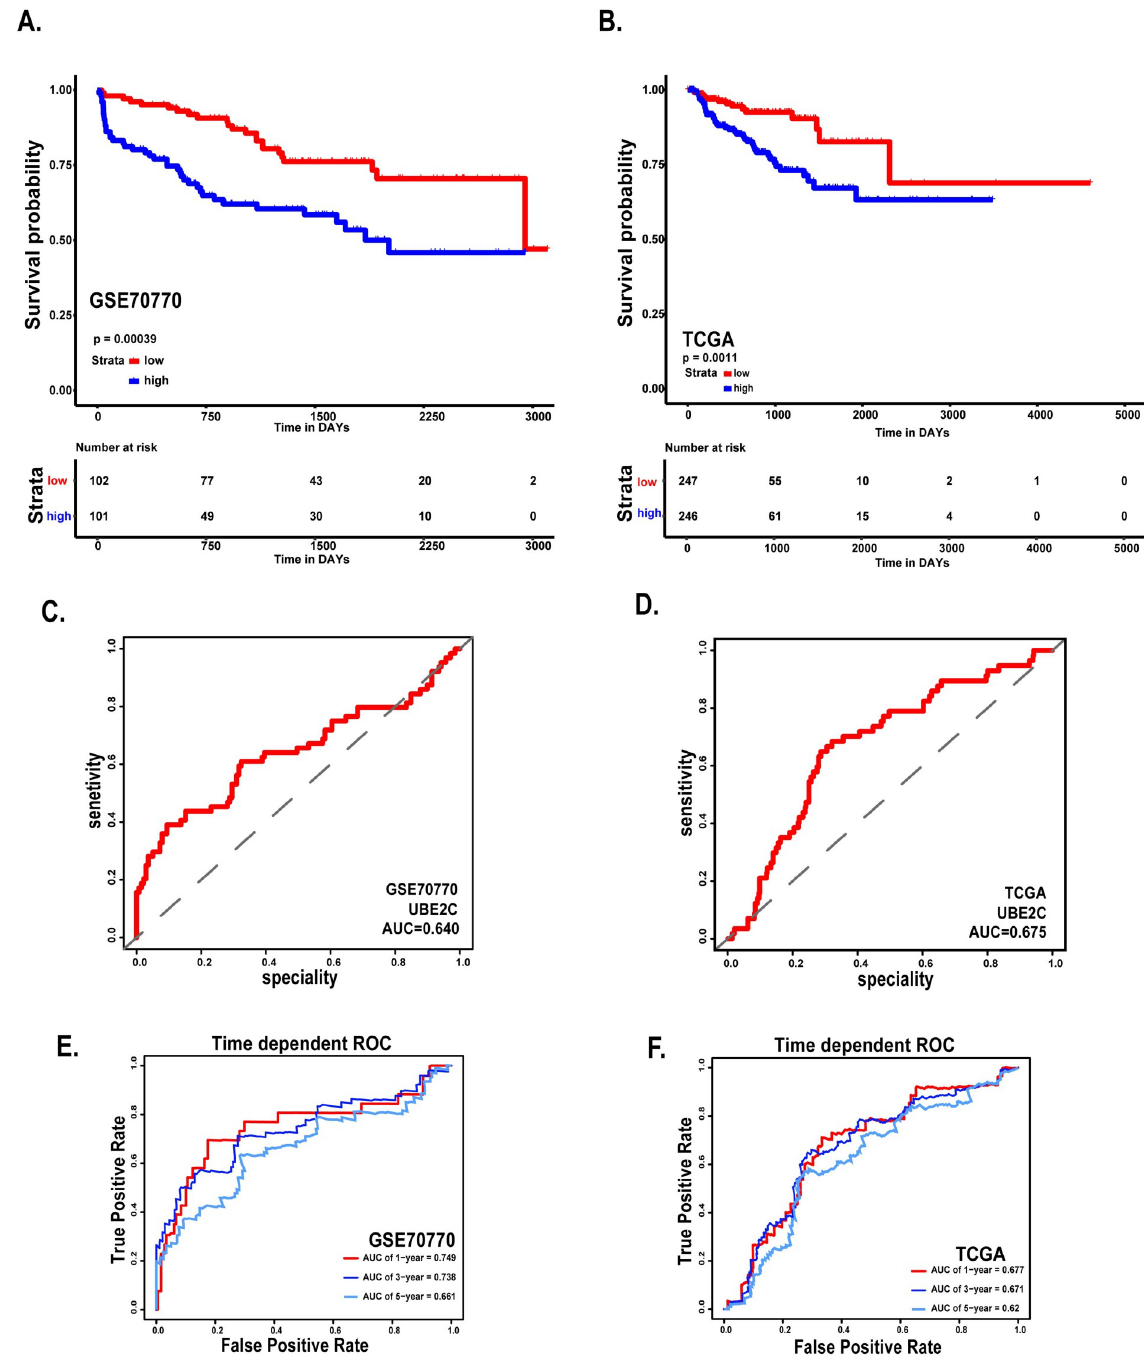
Fig 7. Survival analysis and ROC curve of UBE2C in GSE70770 and TCGA. (A) Disease free survival of patients based on the expression of UBE2C in GSE70770. (B) Disease free survival of patients based on the expression of UBE2C in TCGA. (C) ROC curve of UBE2C in GSE70770. (D) ROC curve of UBE2C in TCGA. (E-F) Time-dependent ROC curves. The AUCs at 1, 3, and 5 years were used to assess prognostic accuracy (left: GSE70770, right: TCGA). � : p < 0.05; �� : p < 0.01; ��� : p < 0.001; ���� : p < 0.0001.